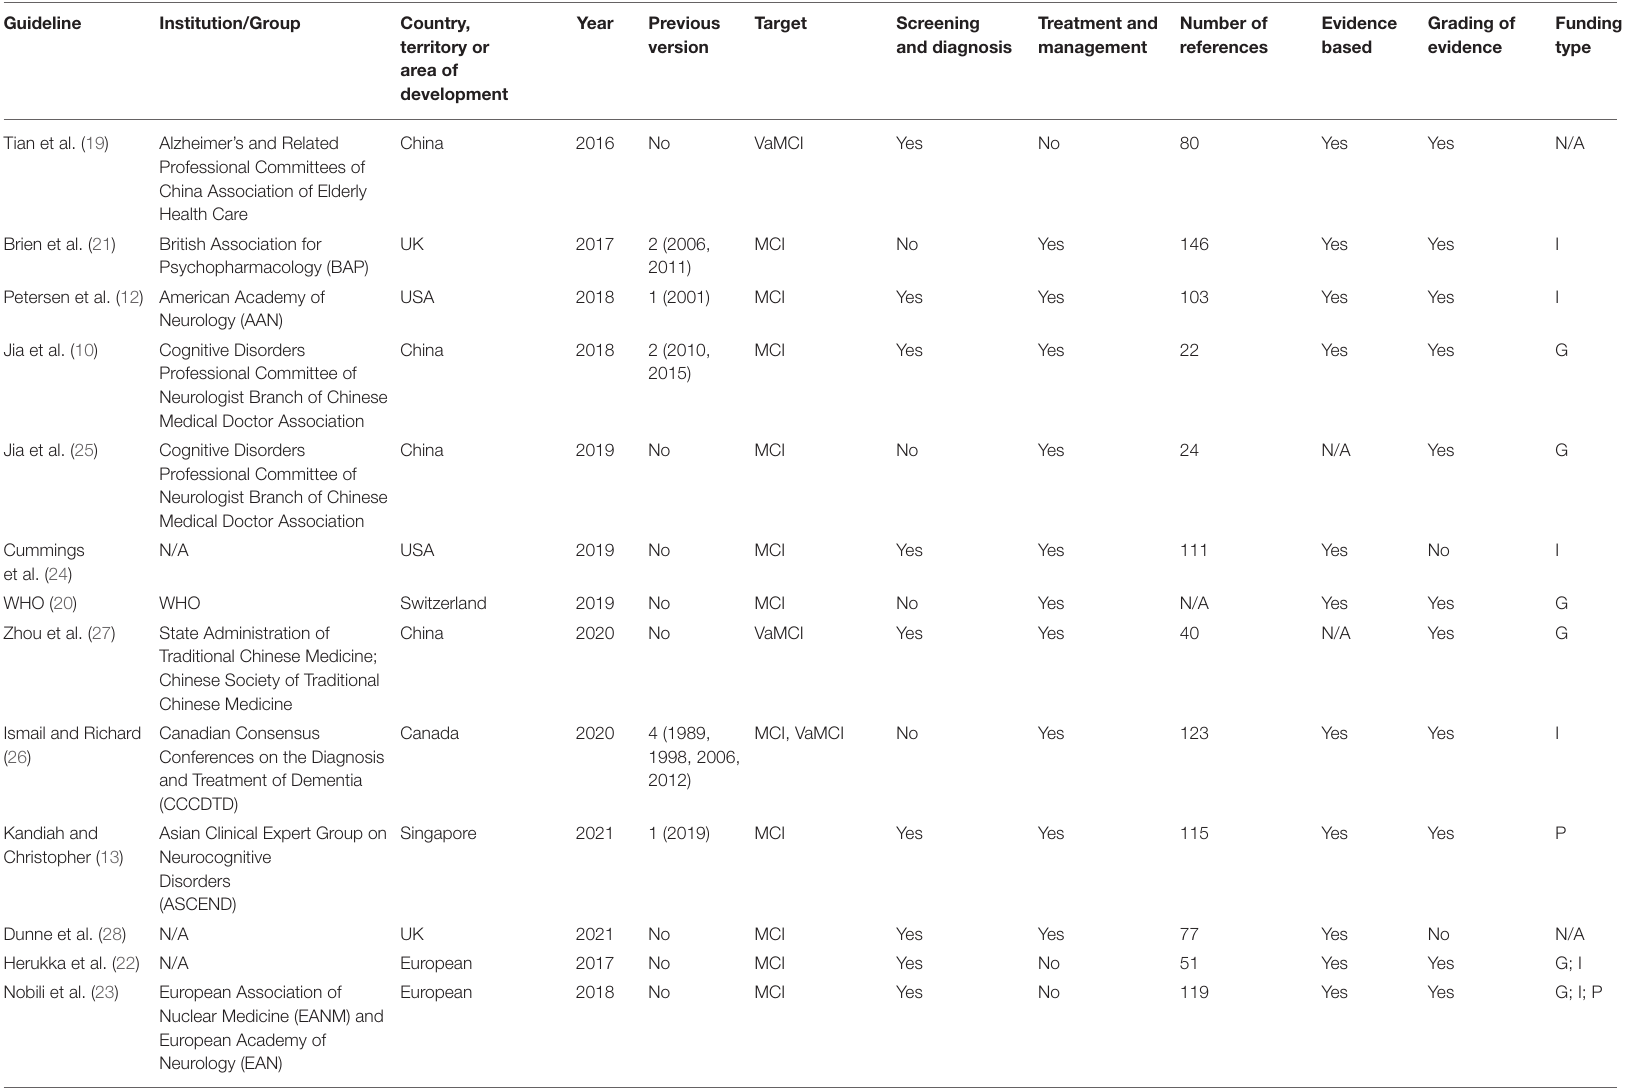
TABLE 1 | Guidelines and consensus statement included in this